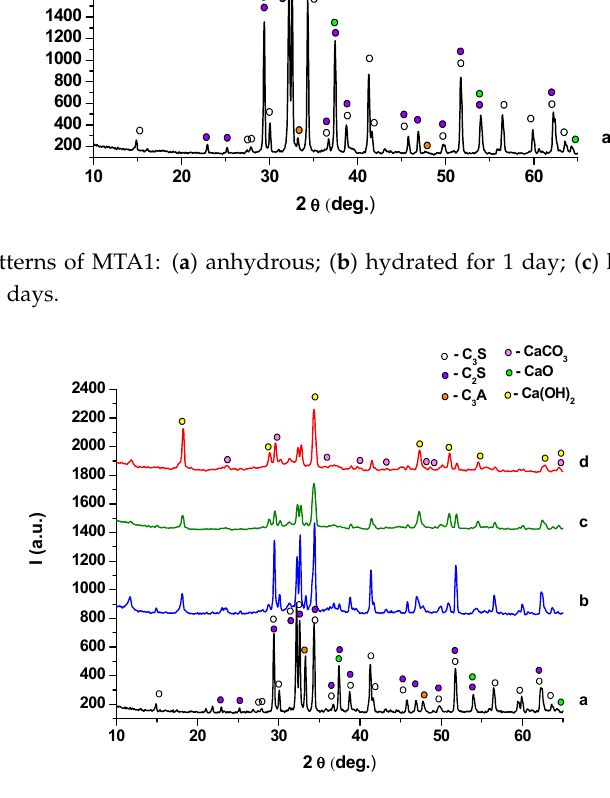
Figure 4. XRD patterns of MTA2: ( a ) anhydrous; ( b ) hydrated for 1 day; ( c ) hydrated for 7 days; ( d ) hydrated for 28 days.